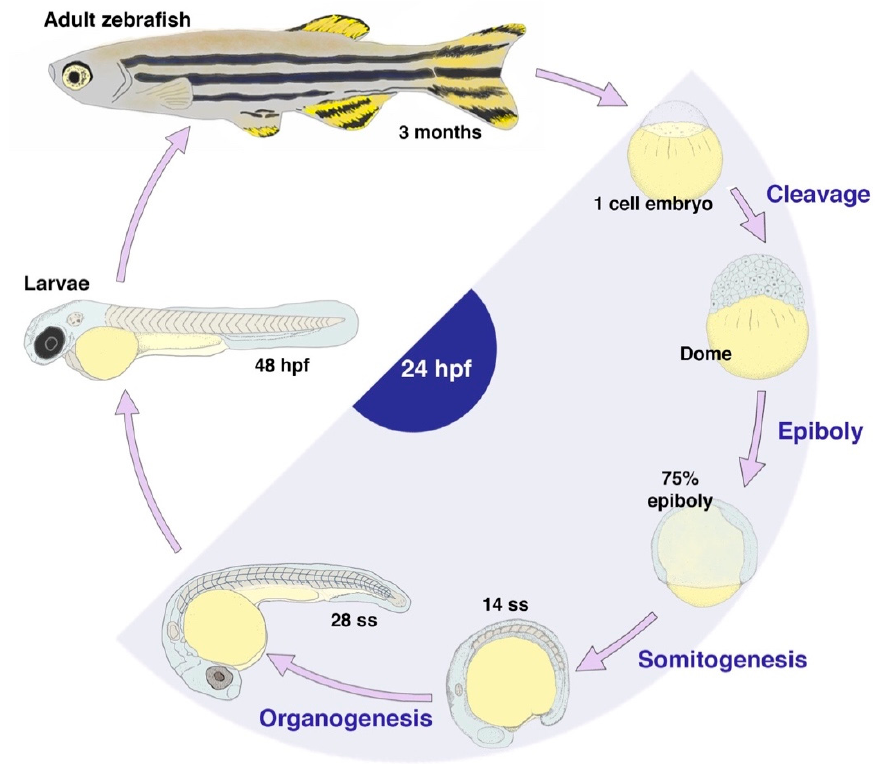
Figure 2. Zebrafish exhibit a rapid life cycle. Embryos are fertilized externally and progress through major developmental stages in the first 24 h post fertilization (hpf) (often denoted by the number of paraxial mesoderm sections, deemed as somite stages (ss)), forming a complete body plan with many major organs. Organogenesis continues through the 48 hpf time point and subsequent days as well, with larvae reaching sexual maturity at approximately 3 months of age.